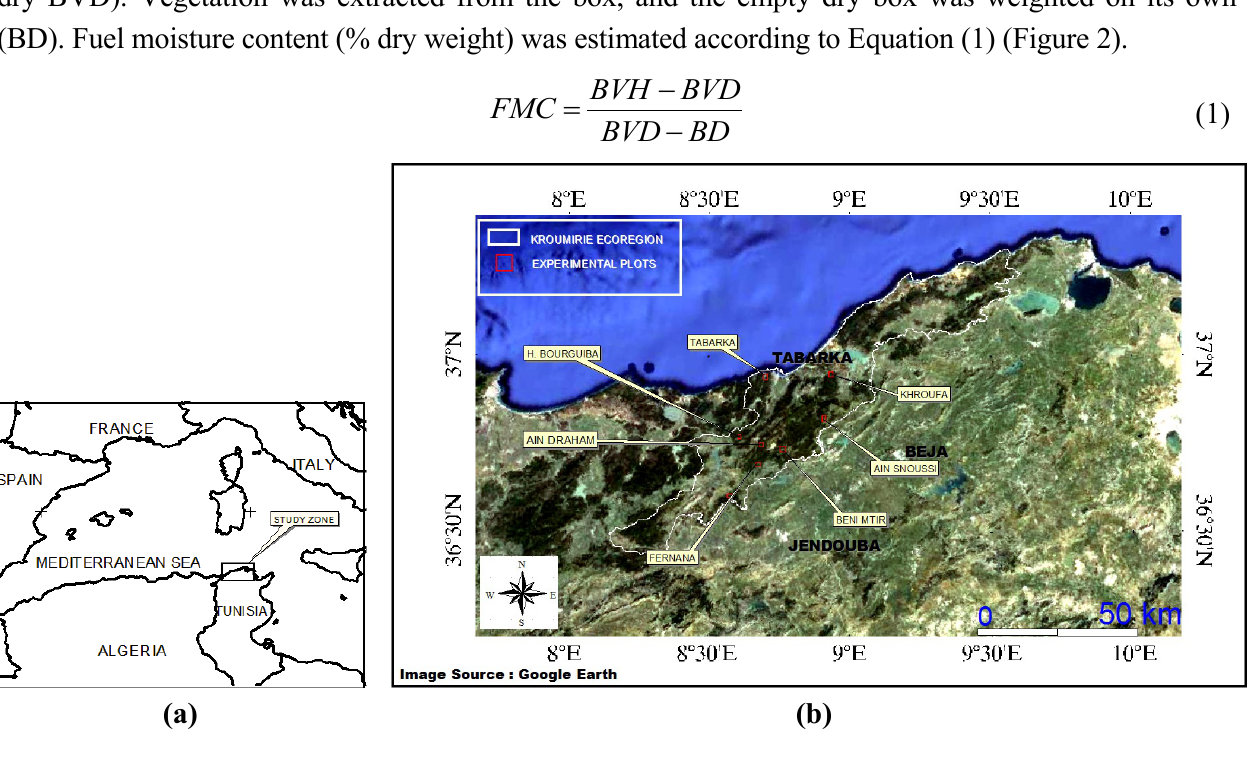
Figure 1. ( a ) General localization of study area. ( b ) Kroumirie ecoregiona and experimental plot localization. Table 3. Study plot location, elevation and vegetation characteristics. Species are composed (2) shrub layer (Ea, Erica arborea , LMA = 0.114 kgC∙m −2 ; Cm, Cistus monspeliensis